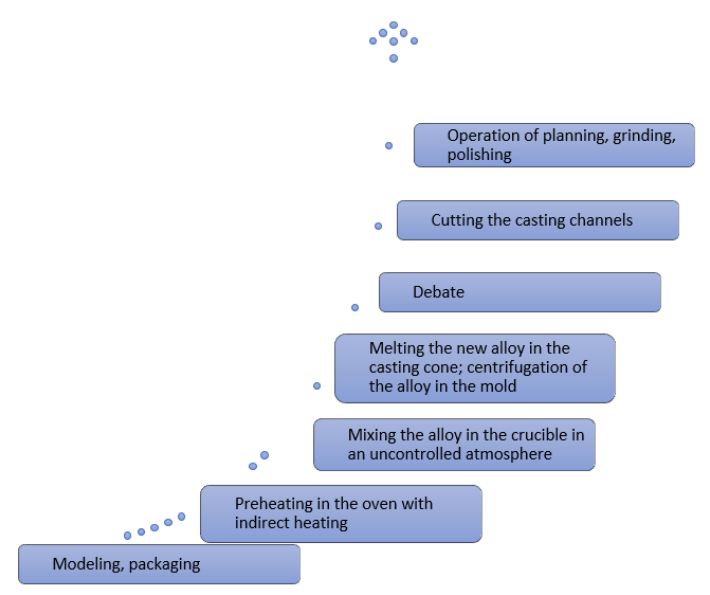
Figure 1. The technological flow of developing the new VeraSoft alloy.